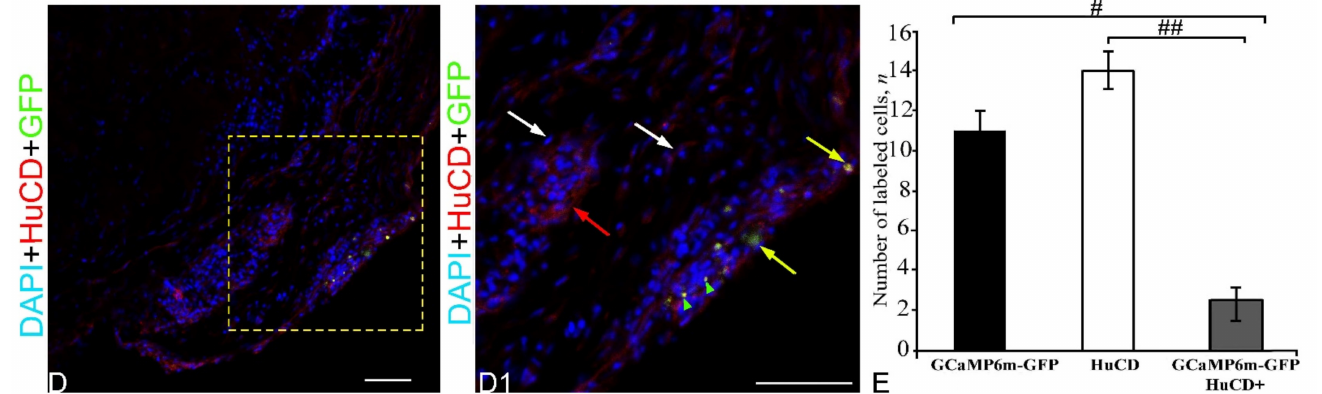
Figure 9. Z-stacks showing DAPI staining, localization of green fluorescent protein GFP and HuCD, and their colocalization in the epiphysis of juvenile chum salmon, O. keta , at 90 days after a single injection of the rAAV into the cerebellar body. ( A ) DAPI staining with a pictogram showing the area of the epiphysis (in a red box); the dotted white box outlines a cluster of DAPI-stained nuclei. ( A1 ) The enlarged fragment outlined by a white dotted box in A; single DAPI-stained nuclei (white arrows). ( B ) Expression of the green fluorescent protein GFP in pineal cells (green dotted square). ( B1 ) The enlarged fragment outlined by green dashed square in B; arrows indicate GFP+ neurons; GFP+ granules (green arrowheads). ( C ) Immunofluorescence of HuCD in pineal cells (in a red dashed square). ( C1 ) The enlarged fragment (in a red dashed square) in C; HuCD+ cells (red arrows). ( D ) Optical overlay of three DAPI/GFP/HuCD staining channels showing areas of GFP/HuCD co-localization in pineal cells (yellow dotted box). ( D1 ) The enlarged fragment outlined by a yellow dotted box in D; cells co-expressing GFP and HuCD (yellow arrowheads), DAPI-stained nuclei (white arrowheads), HuCD+ cells (red arrowheads), and GFP+/HuCD+ granules (green arrowheads). Laser scanning confocal microscopy. Scale bar: ( A , B , C , D ) 200 µ m; ( A1 , B1 , C1 , D1 ) 50 µ m. ( E ) One-way ANOVA showing the relative distribution of GFP and HuCD immunolabeled cells (M ± SD) in the epiphysis of juvenile chum salmon, O. keta . Significant intergroup differences were found in the GCaMP6m-GFP and GCaMP6m-GFP/HuCD (# <0.05) ( n = 5 in each group) and HuCD and GCaMP6m-GFP/HuCD (## <0.01) groups ( n = 5 in each